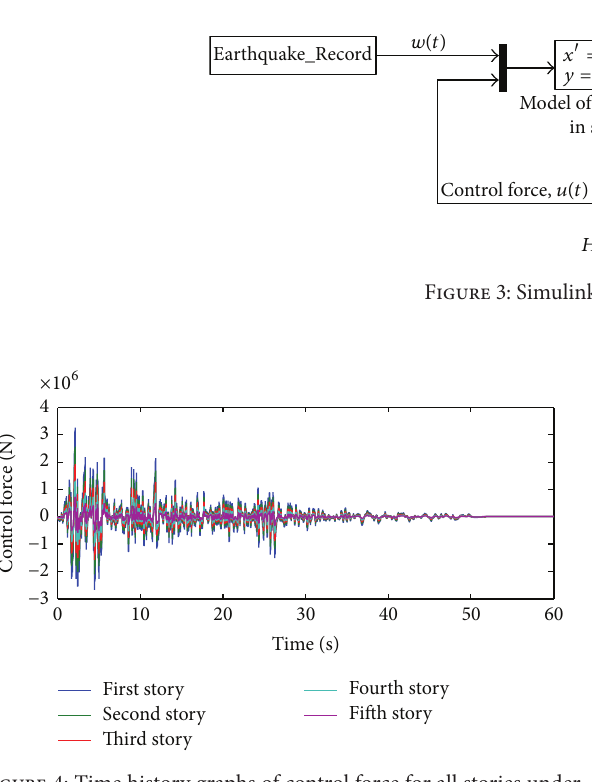
Figure 4: Time history graphs of control force for all stories under El Centro Earthquake (1940), when synchronized control coupled with 𝐻 2 / LQG is used.